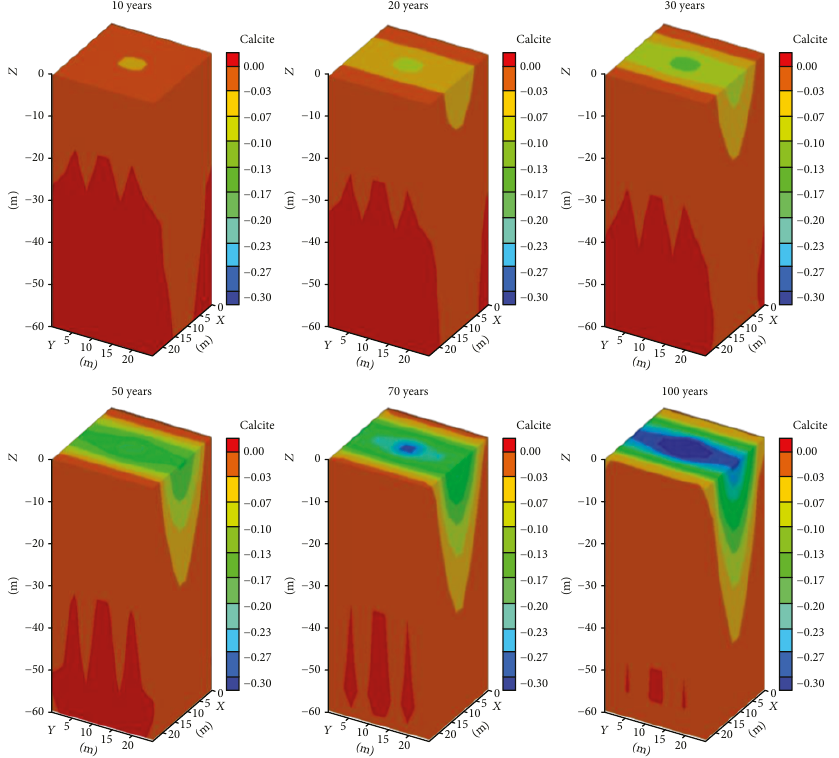
Figure 12: The corrosion range of the fi ssure under medium hydrodynamic conditions-high permeability — 20 °